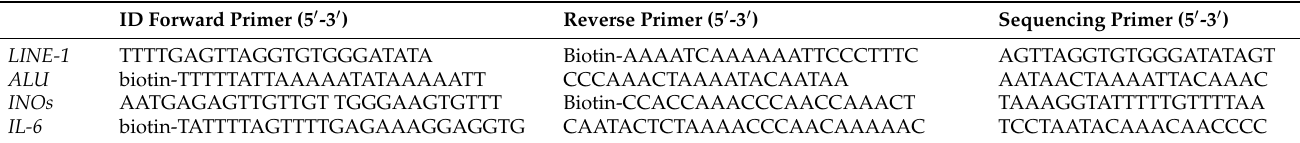
Table 5. Primers for DNA methylation in the repetitive elements of LINE-1 ( Long Interspersed Nuclear Element-1 ) and ALU , and in the promoter domains of the interleukin-6 ( IL-6) and the inducible nitric oxide synthase (i NOS)